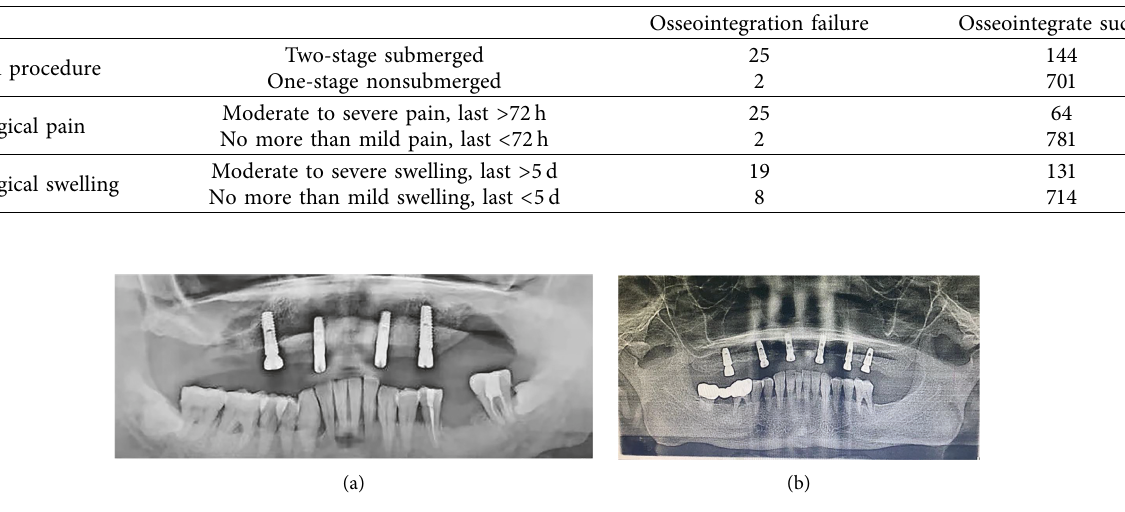
Figure 3: (a) One of the 14th-day postsurgery panoramic examinations. The maxillary right implants failed and were removed in the following weeks. There is no clue detectable for the dental clinician at the current time. (b) The maxillary right premolar region implant was suspected to encounter poor osseointegration when being reviewed on the 7th day and 14th day post surgery; however, it achieved osseointegration in the following weeks and still functions very well in the patient’s mouth for the time being. Table 3: Abbreviations.